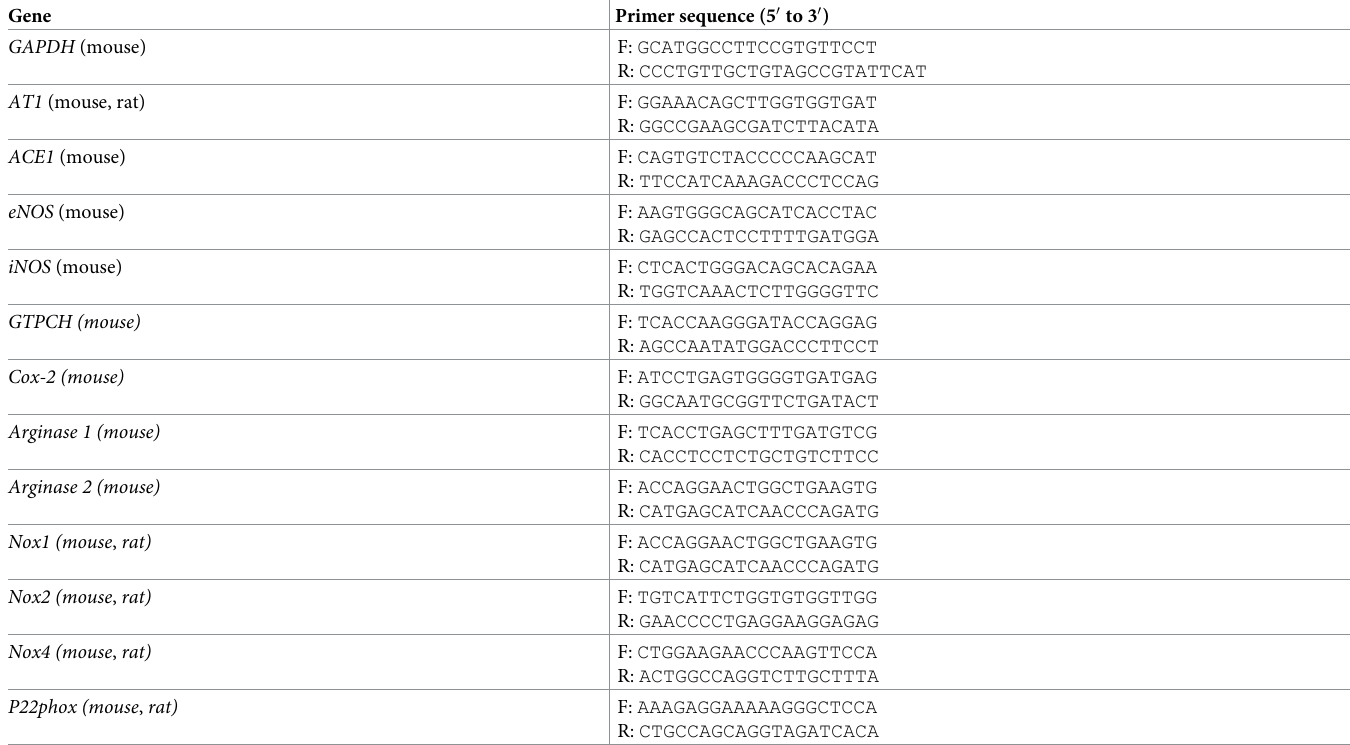
Table 1. Primers for reverse transcription-polymerase chain reaction (RT-PCR).